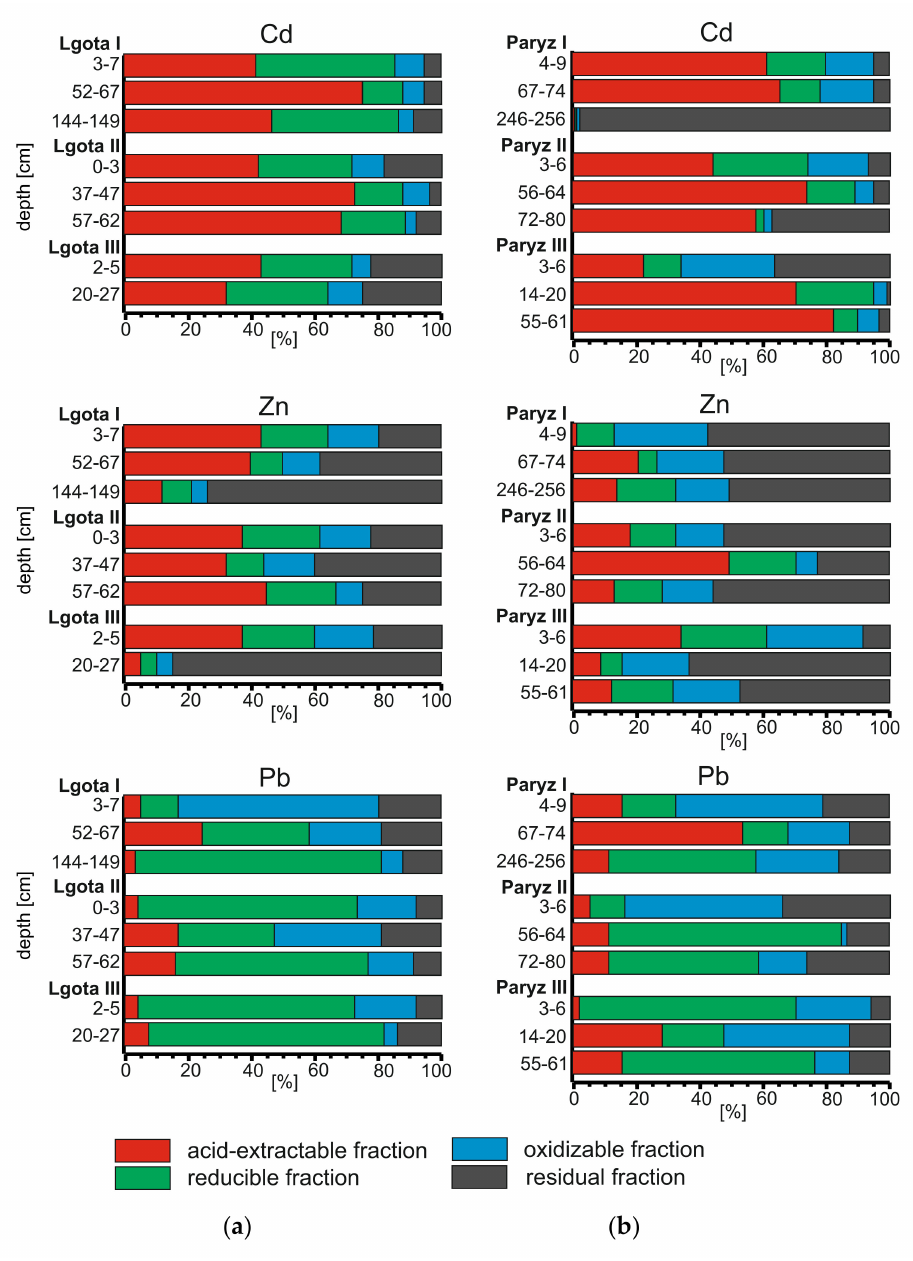
Figure 6. Chemical forms of Cd, Zn and Pb (modified BCR method): ( a ) Lgota, ( b )